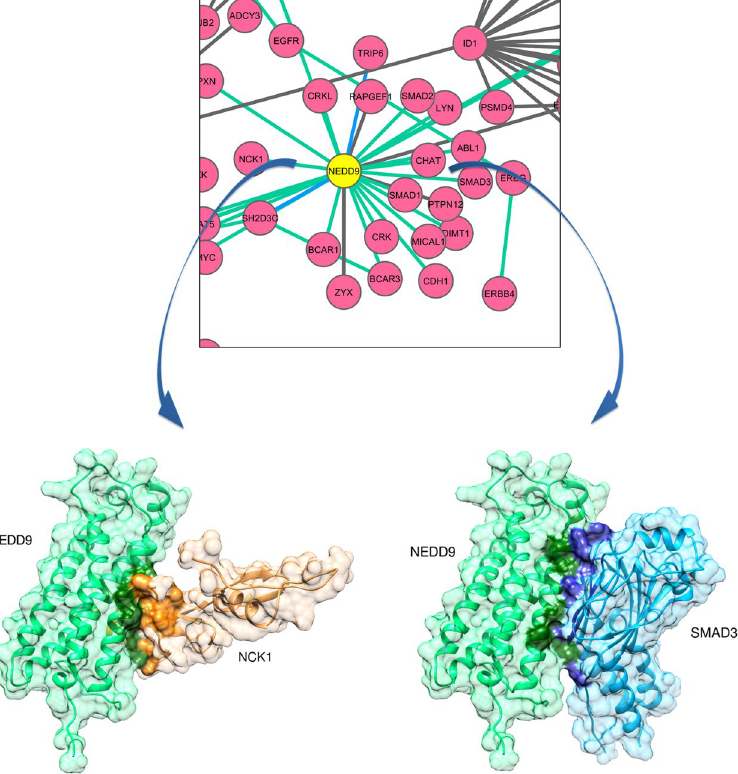
Figure 13. NEDD9 cluster in LMSN and PRISM predictions for its interactions with NEDD9 and SMAD3. (Top) Colour of the edges corresponds to PDB and PRISM coverages. Blue edges are covered by PDB, and green edges are covered by PRISM. (Bottom) Binding residues are indicated with opaque colours in each complex protein